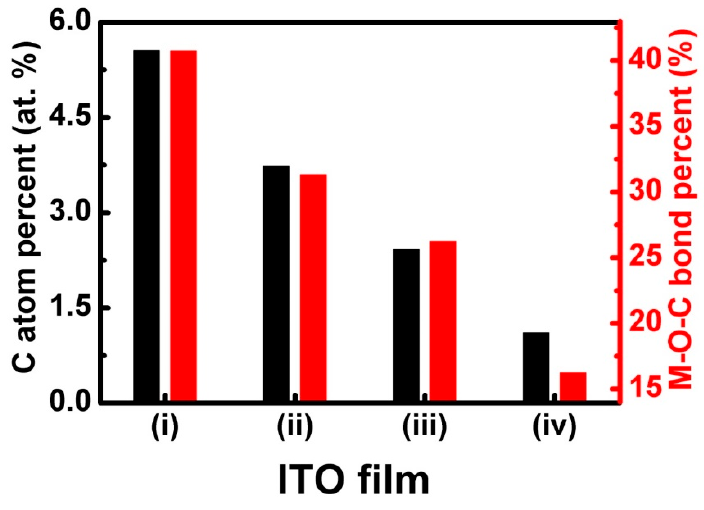
Figure 7. The atomic percentage of C and percentage M–O–C bond from all O bonds.